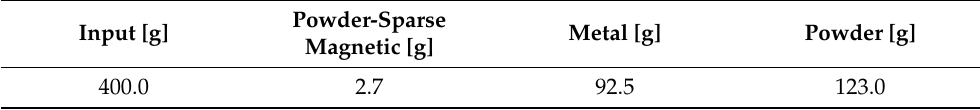
Table 6. Amount of the input and output fractions of the InduMelt experiment in grams.